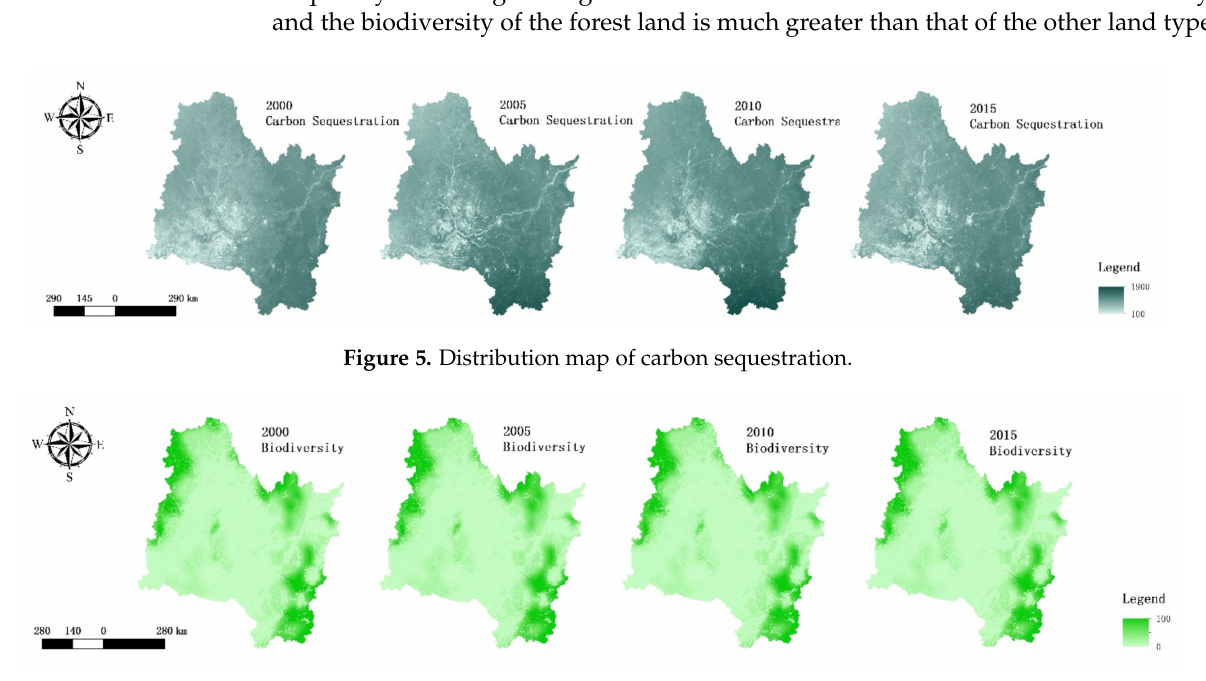
Figure 6. Distribution map of biodiversity.